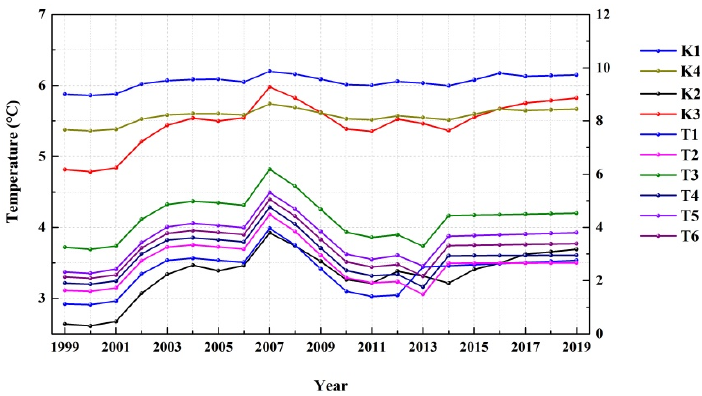
Figure 9. Annual temperature changes in the basins of ten river sections during 1999–2019.